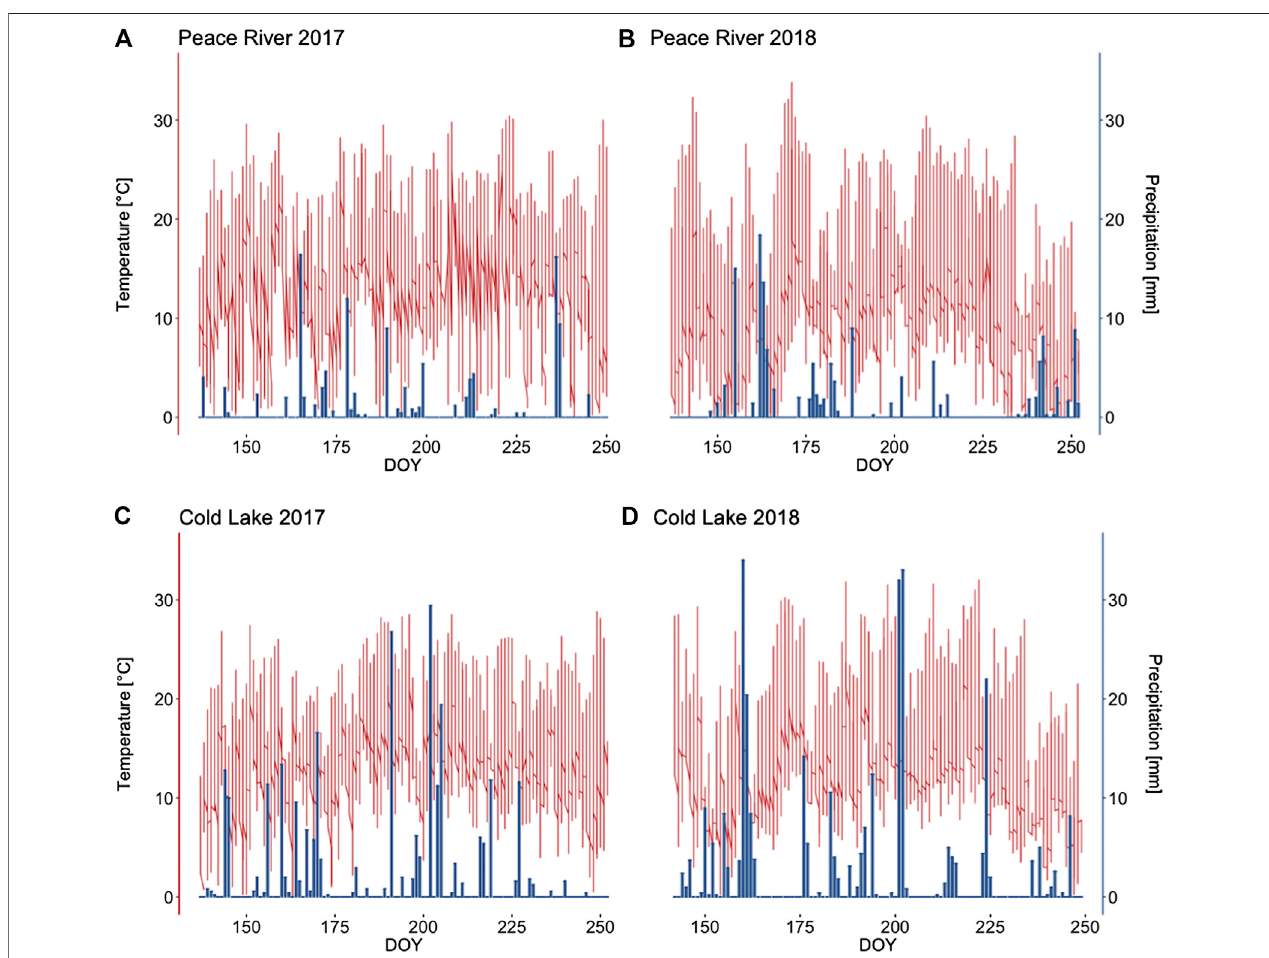
FIGURE 4 | Precipitation (mm) and air temperature ( ° C) measured at a meteorological station on restored in-situ oil sands well pads in the Peace River and Cold Lake Oil Sands, during the monitoring period (May 17 until September 9) in the years 2017 (A + C) and 2018 (B + D) .